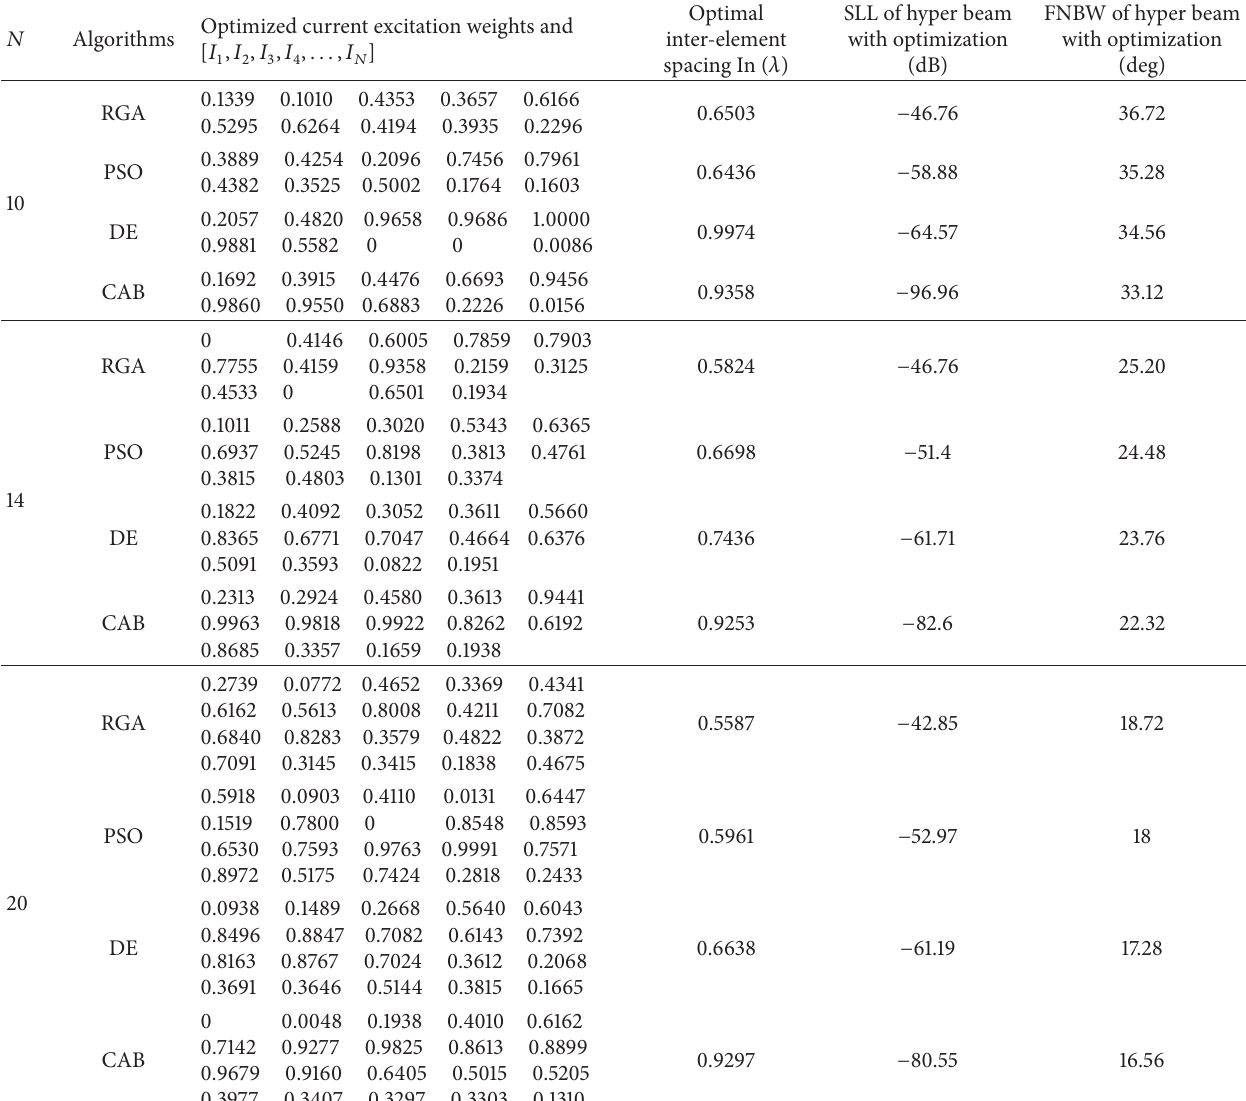
Table 4: SLL, FNBW, optimal current excitation weights, and optimal inter-element spacing for hyper beam pattern of linear array with hyper beam exponent ( 𝑢 = 1 ), obtained by RGA, PSO, DE, and CAB for different sets of arrays. 𝑁 Algorithms Optimized current excitation weights and